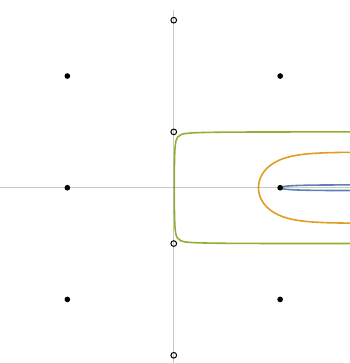
Figure 3. A family of reflected solutions. Pictured here are several solutions with η real and less than w , 0 < ρ 0 < π , and N 1 = 0 , obtained from eq. (4.30) with the principal branch of sinh − 1 . The 2 η solid disks indicate the turning points and the open circles indicate the singularities. The solution hugging the real axis has ρ 0 just above zero, corresponding to the real solution that rolls up and down the same side of the inverted-potential. All trajectories related by continuously dialing ρ 0 have the same action, unless one hits a singular trajectory in the process. The green solution pictured is nearly singular, with ρ 0 just below π . At that value the trajectory will hit the poles of the potential. 2 η